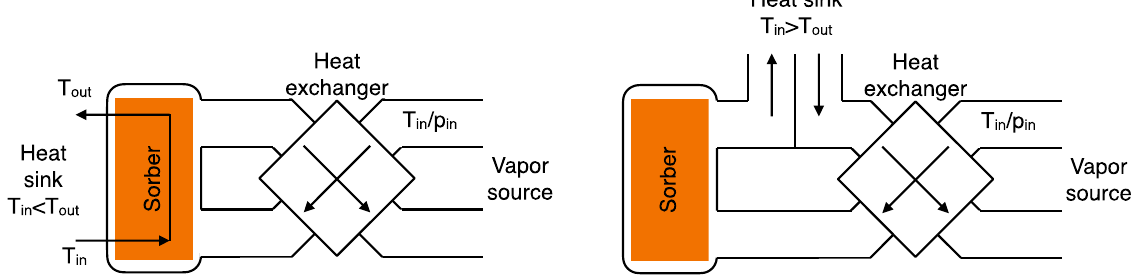
Figure 3. Illustration of the open fixed process with air to air heat exchanger and separated heat release, liquid on the left and air-bound on the right.